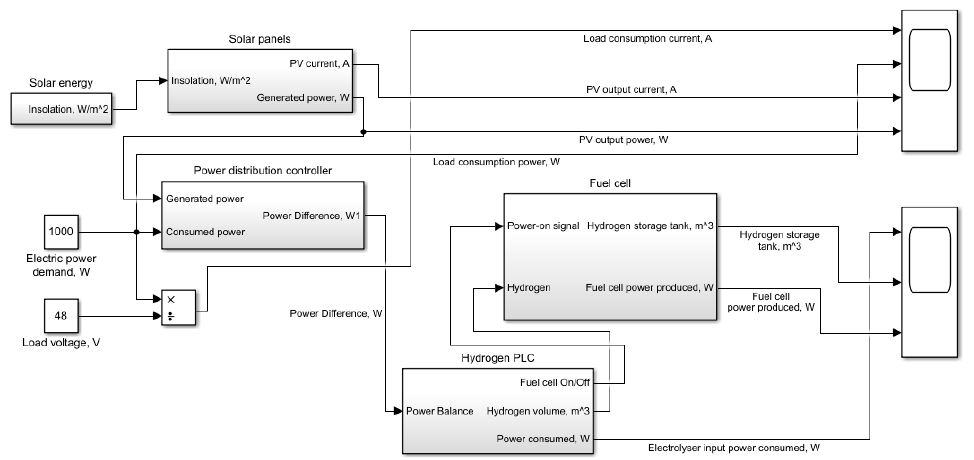
Figure 13. The complete model of the photovoltaic powered hydrogen generation system in Matlab/Simulink.